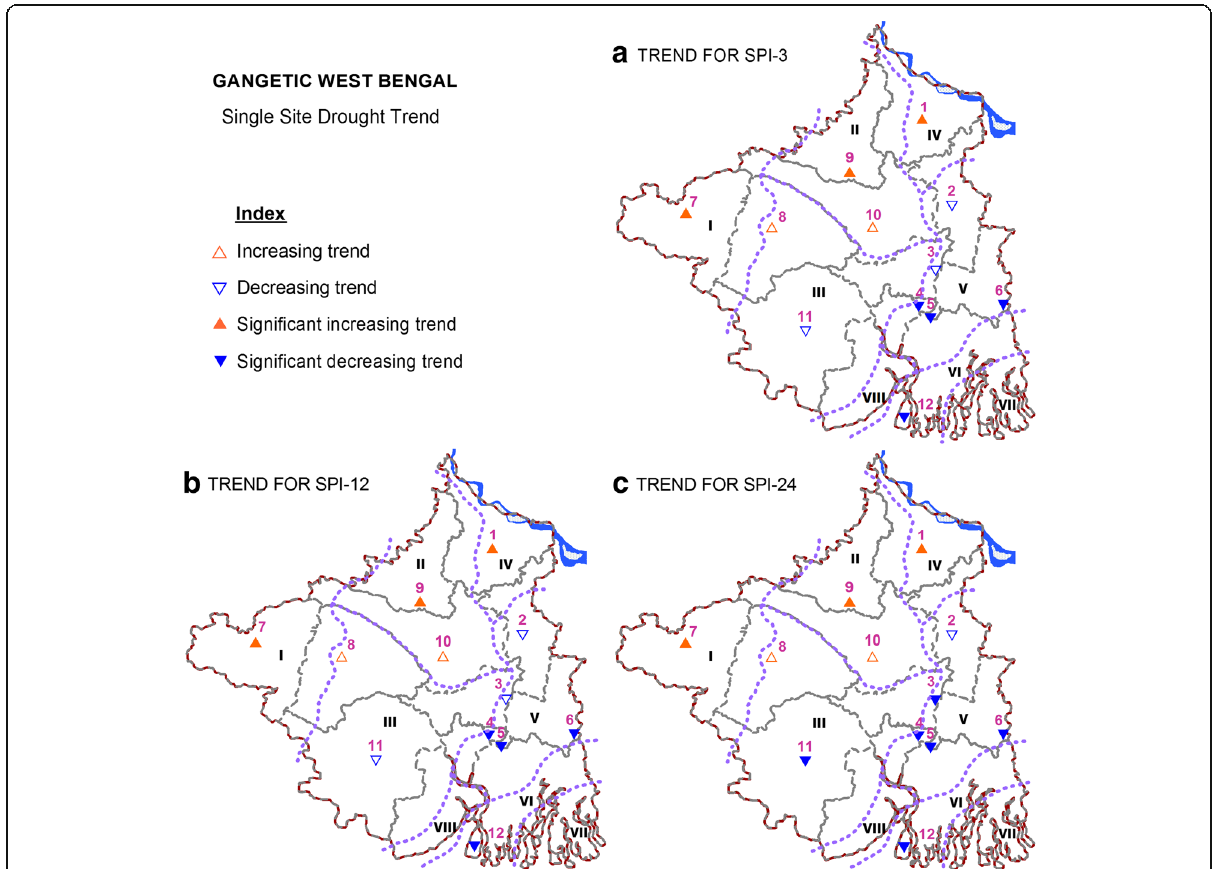
Fig. 13 Single-site trend of drought intensity (1901-2002) for SPI at ( a ) 3-, ( b ) 12- and ( c ) 24-months time scales